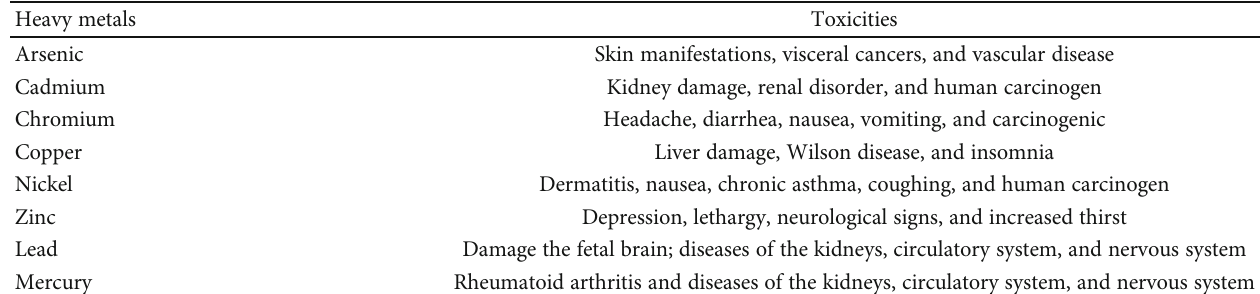
Table 1: The toxicities of some heavy metals [15].